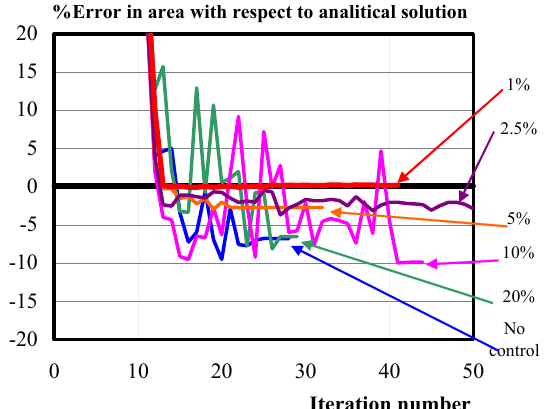
Fig. 8. Deterministic algorithm. Influence of γ over the evo- lution of the difference between the obtained objective function and the analytical solution